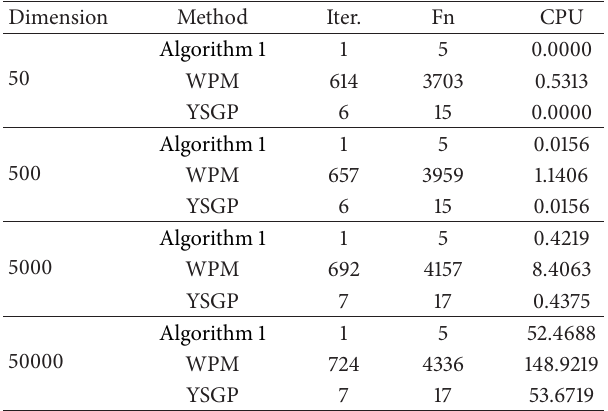
Table 1: Numerical results with different dimensions of Problem 11.